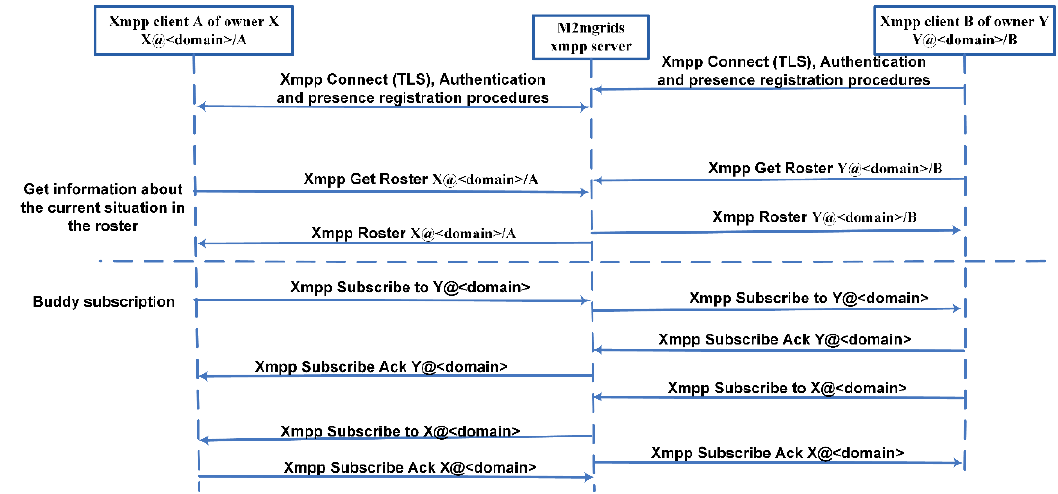
Figure 14. XMPP buddy subscription.